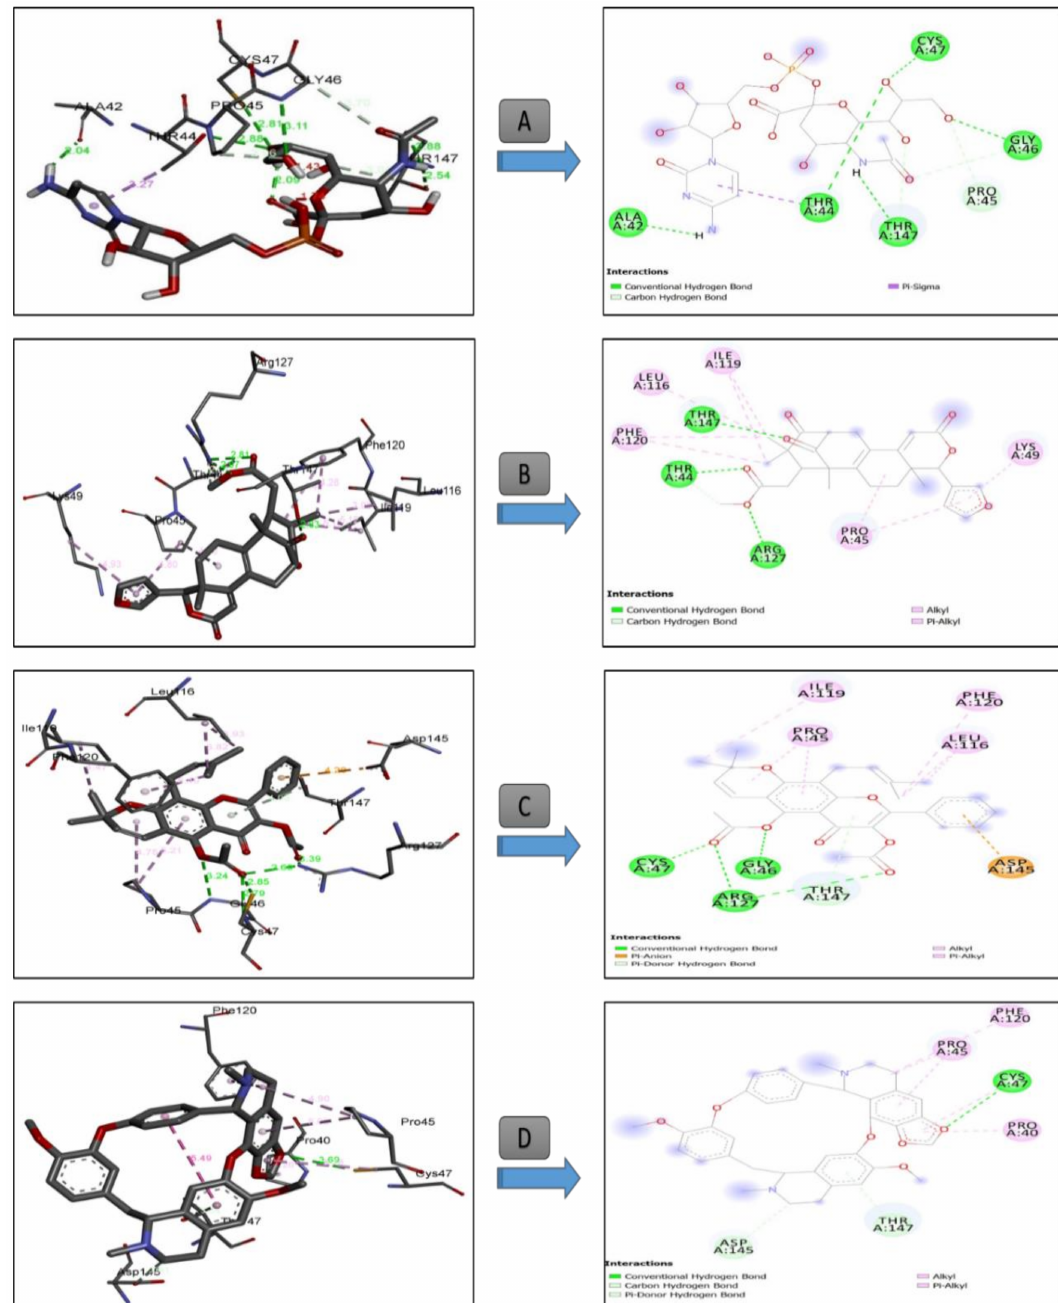
Figure 4. Three-dimensional ( right ) and two-dimensional ( left ) closest interactions between active site residues of peroxiredoxin 5 and some molecules belonging to di ff erent class compounds with the best score result. Legend: ( A ): Compound 13 (CMP-N-acetylneuraminic acid, Class: Amino Sugar), ( B ): Compound 14 (Carapin-8 (9)-Ene, Class: Limnoid), ( C ): Compound 10 (Sericetin diacetate, Class: Flavonol), and ( D ): Compound 8 (Cepharantine, Class: